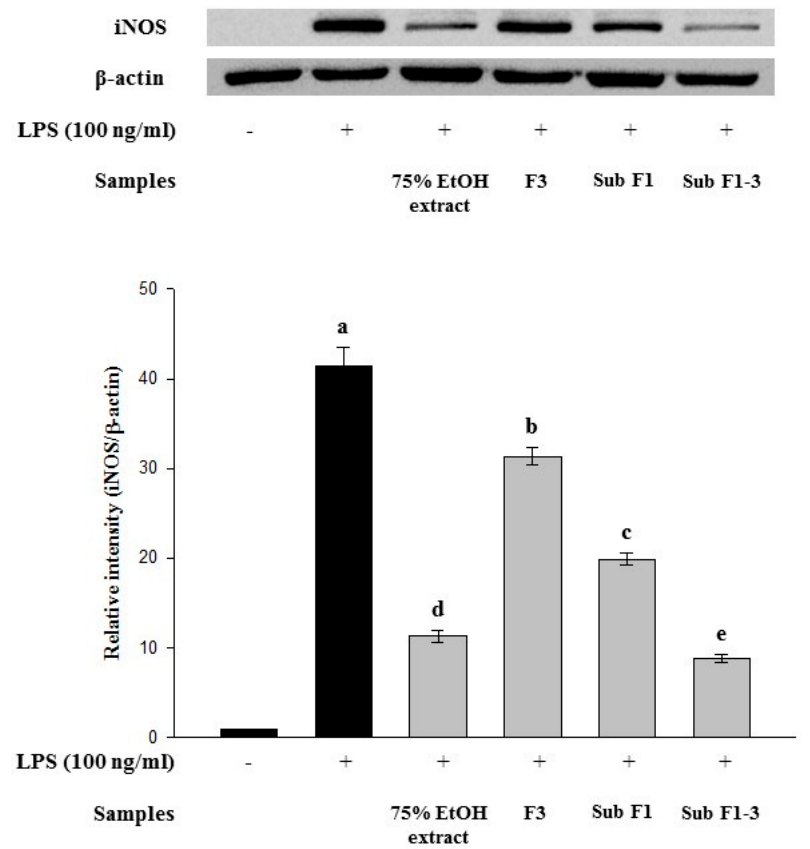
Figure 2. Effect of Actinidia arguta leaves extracts and its partially purified fractions on inducible nitric oxide synthase (iNOS) expression in lipopolysaccharide (LPS)-induced RAW 264.7 cells. Cells were treated with LPS (100 ng/mL) as well as the extracts and their partially purified fractions (50 µ g/mL) for 20 h. Cell lysates were prepared and subjected to Western blotting using antibodies specific for iNOS and β -actin. Data are expressed as mean ± SD after triplicate analysis. Different letters indicate significant differences compared with LPS control at p < 0.05. (F3: fraction 3, Sub F1: sub-fraction 1, and Sub F1-3: sub-fraction 1-3).